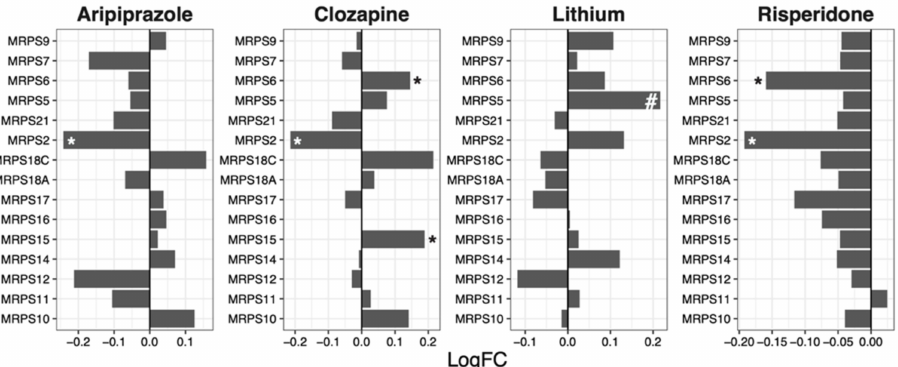
Figure 3. Effects of psychotropic drugs on the expression of genes encoding components of the mitochondrial ribosomal 28S subunit. FC = Fold change, * p < 0.05, # q <